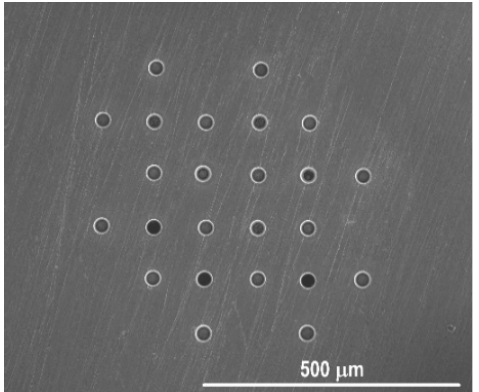
Figure 1. Scanning electron microscopy (SEM) image of a set of wells patterned on T91 steel by means of focused ion beam (FIB).